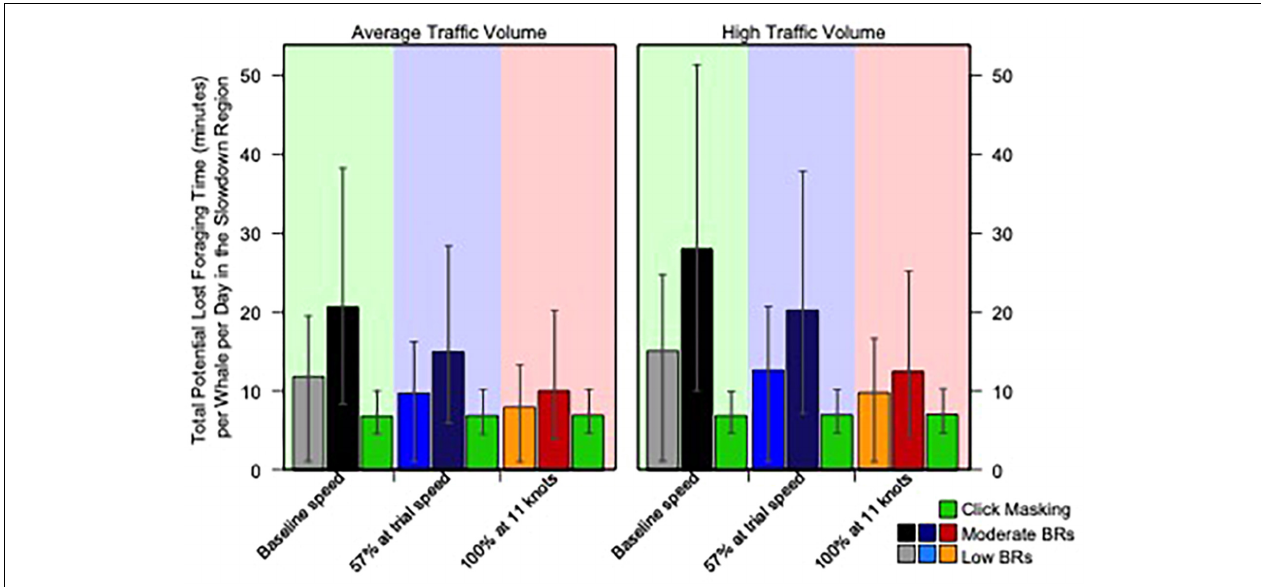
FIGURE 8 | Modeled SRKW ‘Potential Lost Foraging Time’ for each of the six Vessel Speed and Traffic Scenarios (Scenarios 1 through 6, Table 2 ). Bars show ‘Potential Lost Foraging Time’ for each of Low BR, Mod BR, and Click Masking as determined by the SRKW noise-exposure simulation model. Average and High Traffic Volume Scenarios corresponds to the descriptions in Table 2 . The reduction in ‘potential lost foraging time’ attributable to moderate BRs declined by > 50% in model scenario when all vessels observe speeds of 11 knots (compared to Baseline; i.e., by comparing heights of black to red bars).